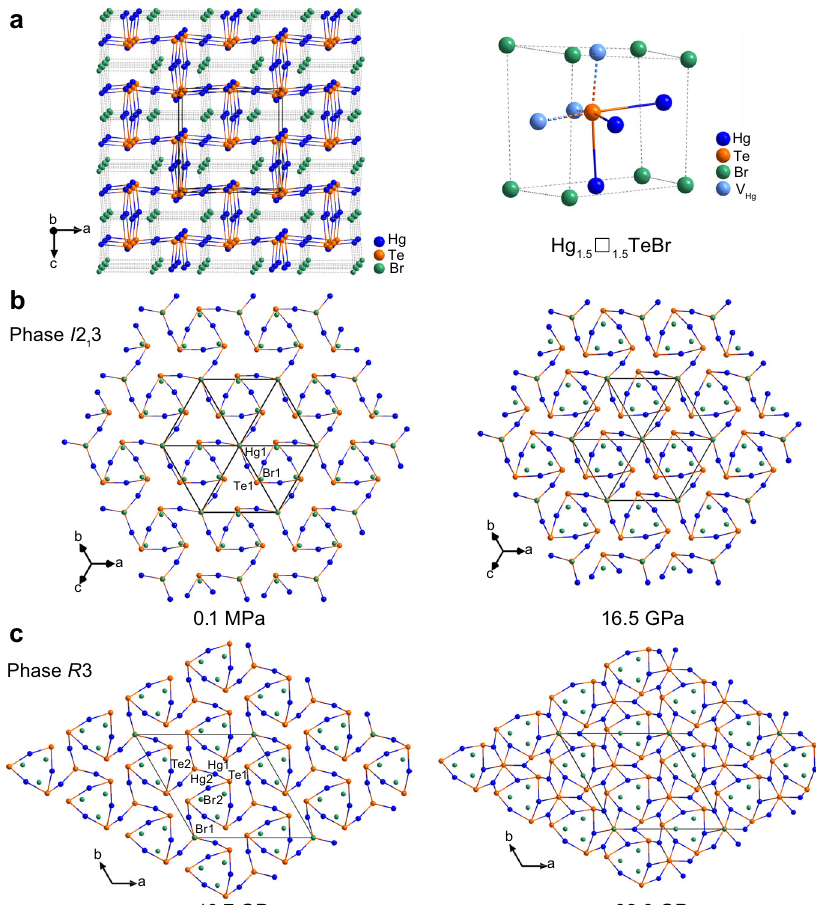
Fig. 2 Crystal structures of Hg 3 Te 2 Br 2 at different pressures. a Structure of phase I of Hg 3 Te 2 Br 2 viewed approximately along the [010] direction at 0.1 MPa. The defect antiperovskite structure of Hg 1.5 & 1.5 TeBr, with 50% of Hg atoms missed (perovskite-lime pseudo-cage shown). b Phase I at 0.1 MPa (left) and 16.5 GPa (right) viewed along the [111] direction. c Phase II at 18.7 GPa (left) and 32.3 GPa (right) viewed along the c -axis. The coordination numbers of Te1 and Te2 atoms increase under pressure are shown in 32.3 GPa (Supplementary Fig. 5). All the Hg – Br bonds are omitted for